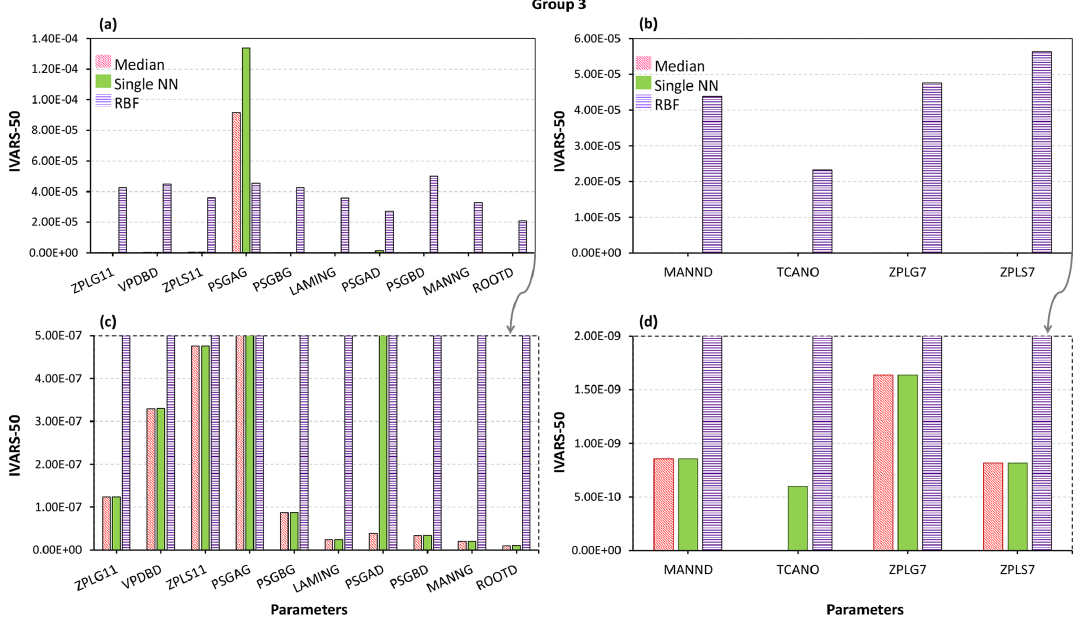
Figure 13. Sensitivity analysis results of the MESH model using different crash-handling strategies for weakly and/or non-influential pa- rameters in Group 3 (see Fig. 10). Panels (c) and (d) show a zoomed-in view of panels (a) and (b) for very small values on the vertical